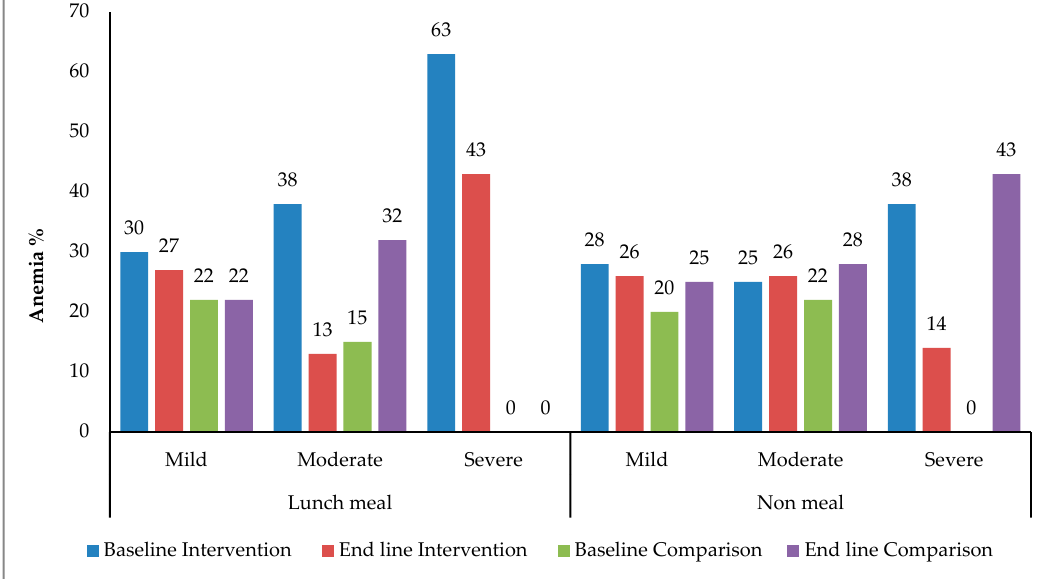
Figure 3. Changes in severity of anemia over time.